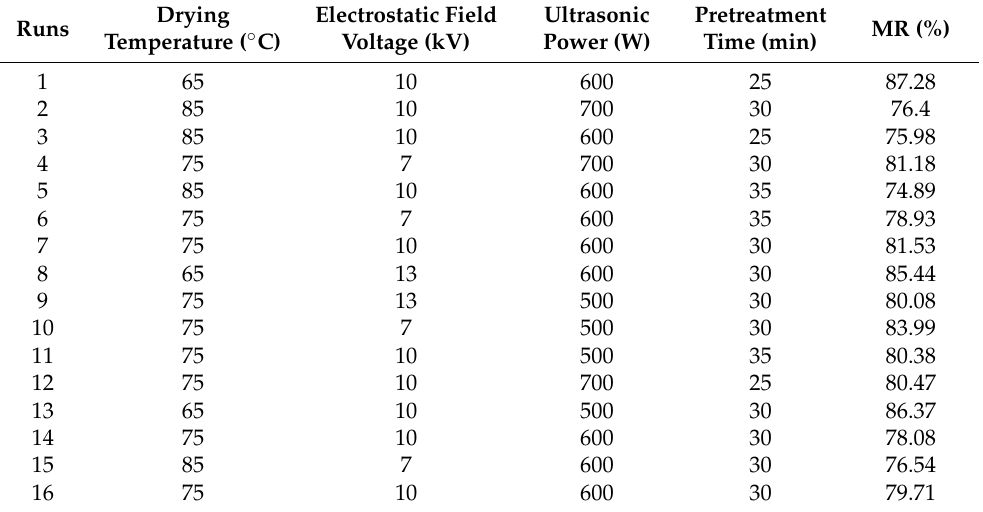
Table 2. Factors and levels of design and layout of response surface center composite experimen- tal